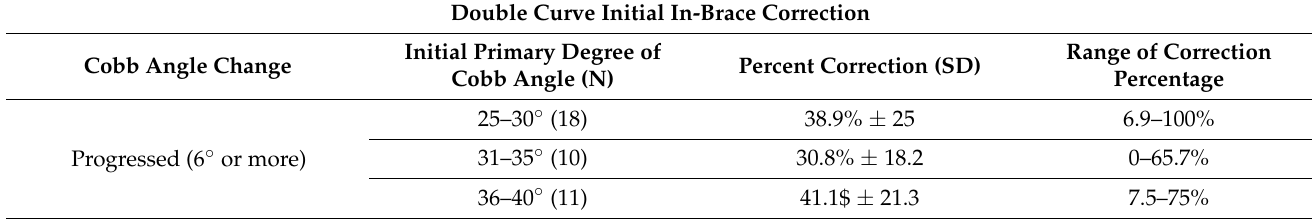
Table 7. Initial in-brace correction for double curves. Double Curve Initial In-Brace